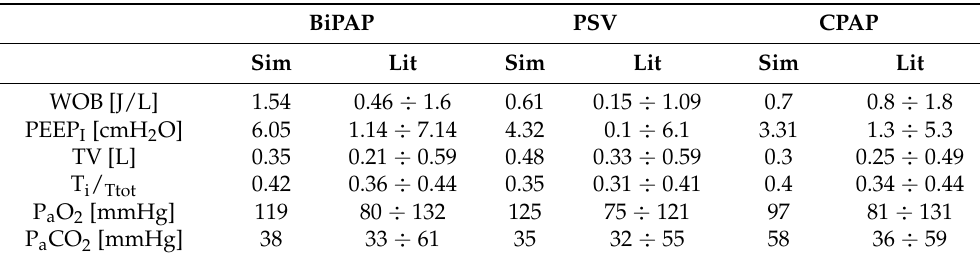
Table A2. Comparison of simulation results with clinical data from [71]. BiPAP , PSV , CPAP — ventilatory support with the biphasic positive airway pressure, the pressure support ventilation, and the continuous positive airway pressure, respectively. Sim, Lit—results of simulations and clinical, respectively. See the note for the Table A1 for other